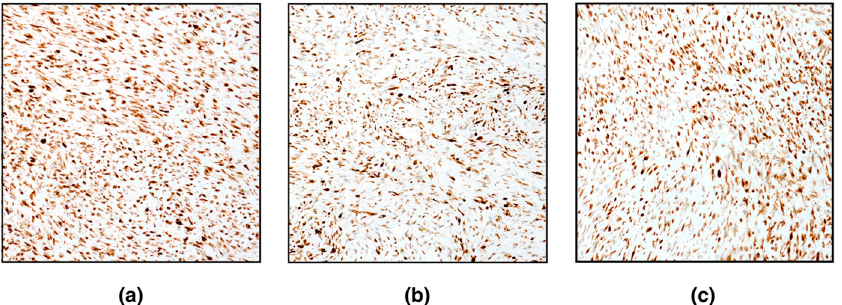
Figure 3. Immunohistochemical characterization of leiomyoma, ovary, white tiger. (a) Vimentin, (b) b ) desmin, and ( c ) caldesmon expression (magnification 200 × desmin, and (c) caldesmon expression (magnification 200×). (